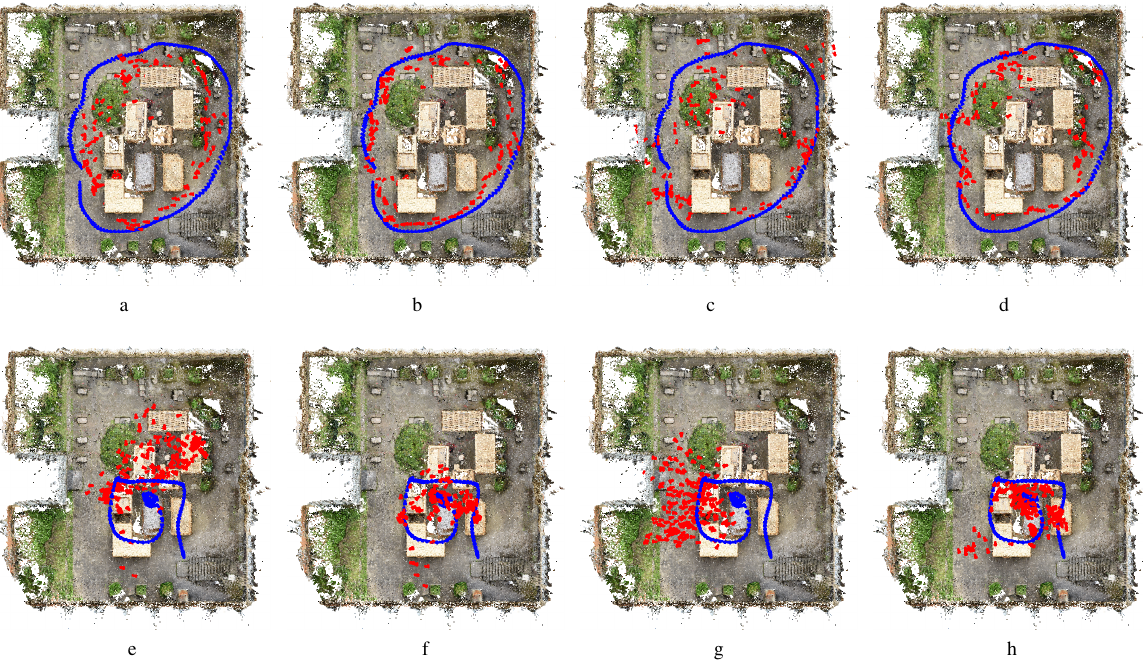
Figure 6. Visualization of estimated poses (red) and ground truth poses (blue). a) VGG16-Net trained on the Real data set. b) VGG16- Net trained on the Real+Diverge data set. c) SqueezePoseNet trained on Real data set. d) SqueezePoseNet trained on Real-Coincide data set. e) VGG16-Net trained on the Real data set. f) VGG16-Net trained on the Coincide data set. g) SqueezePoseNet trained on Real data set. h) SqueezePoseNet trained on Diverge data